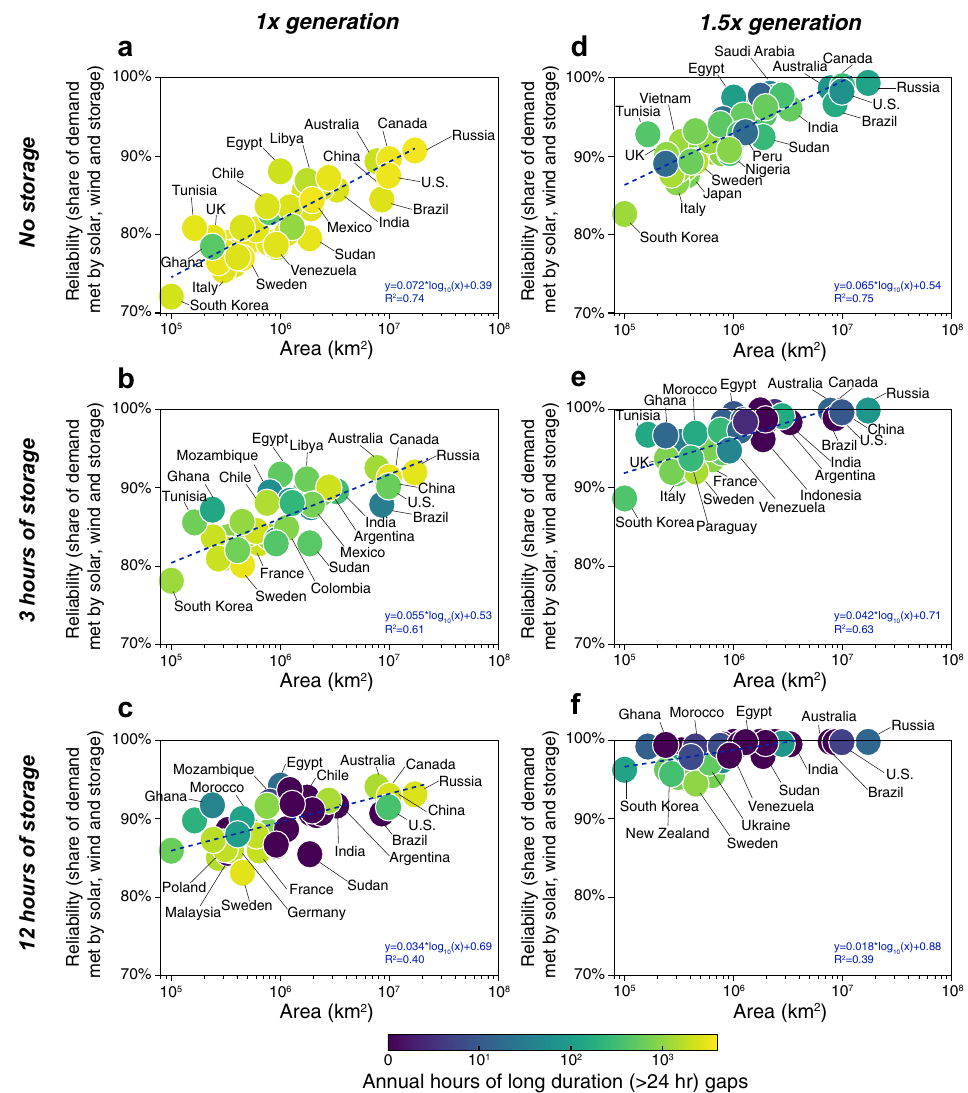
Fig. 3 The relationship between the highest reliability of electricity supply system and country area among 42 major countries. Shading of bubbles represents the annual average hours of long-duration (>24 h) power supply gaps. Storage and generation quantities are varied in each panel: a 1x generation without storage; b 1x generation with 3 h of storage; c 1x generation with 12 h of storage; d 1.5x generation without storage; e 1.5x generation with 3 h of storage; and f 1.5x generation with 12 h of